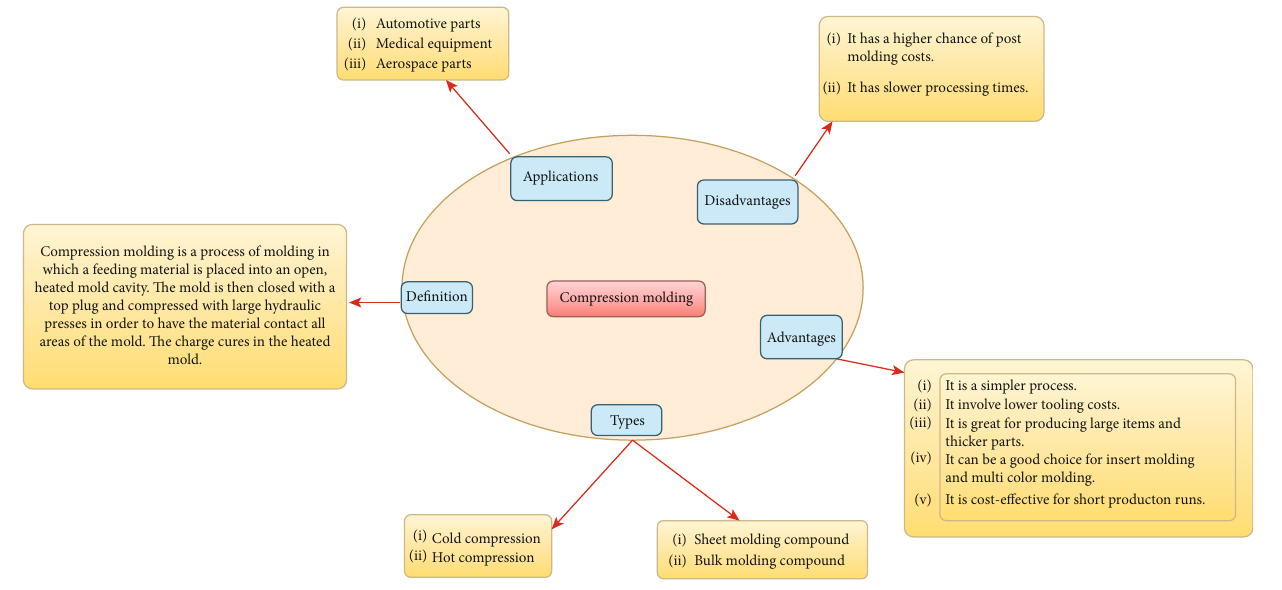
Figure 1: Advantages and application of compression moulding.